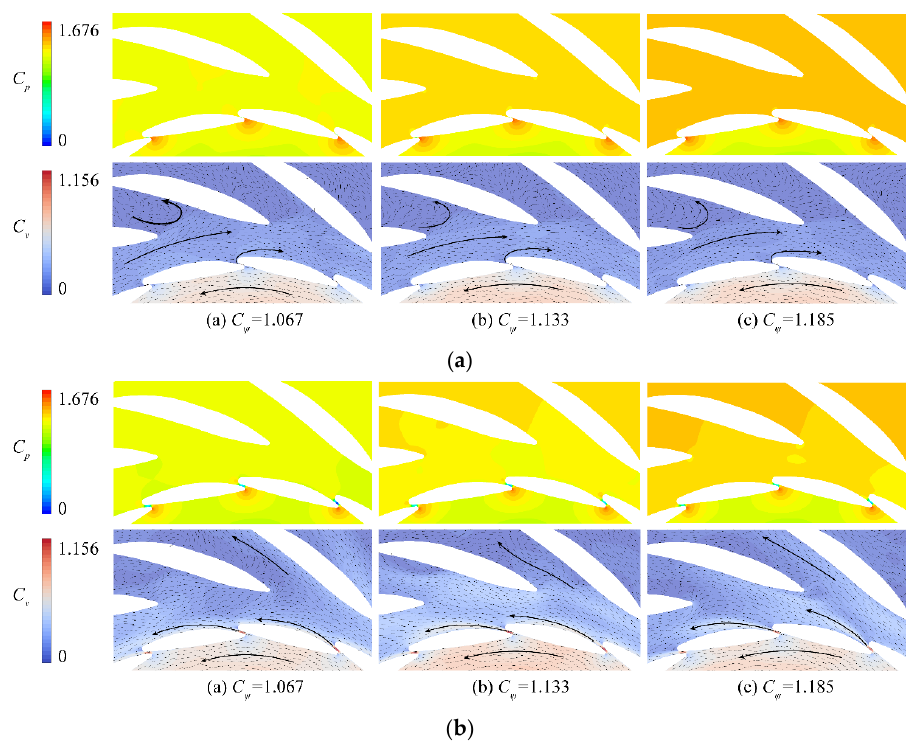
Figure 14. Contours of C p and contours of C v with vectors on the mid-section plane head coefficients under the example condition of α = 0.2° and α = 1° for GV-O. ( a ) α = 0.2°; ( b ) α = 1°.